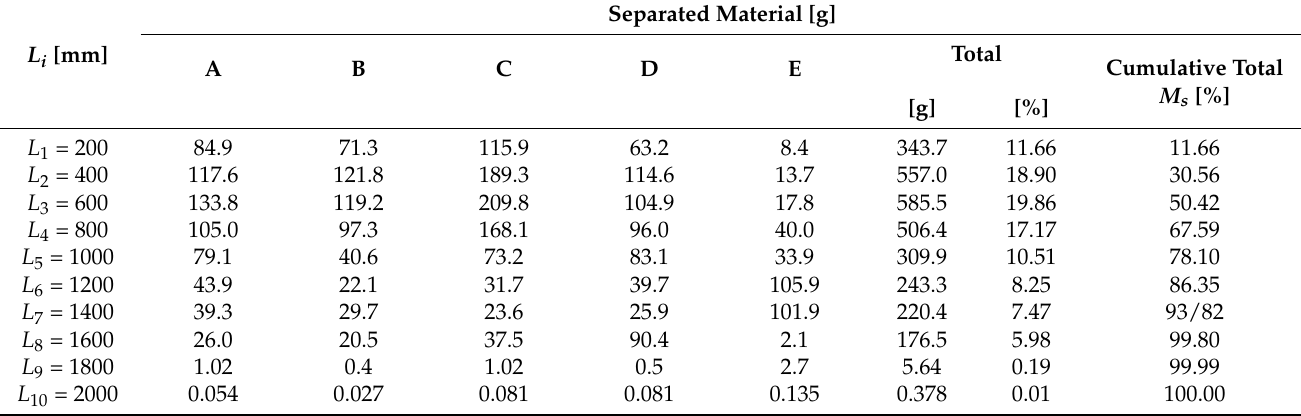
Table 2. The total separated material (straw + seeds), M s , on each section of the threshing apparatus length L (values expressed in [g], respectively [%], and cumulatively